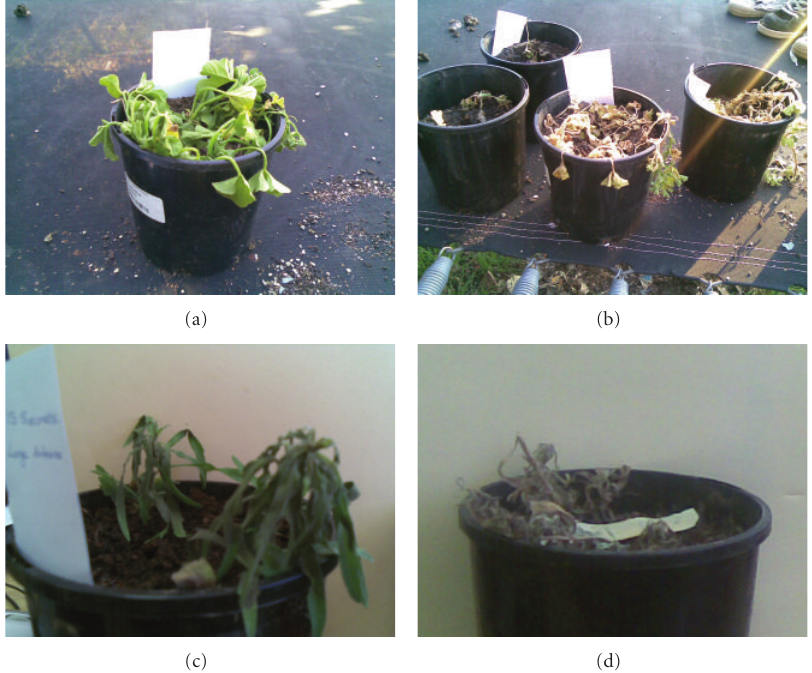
Figure 3: Paddy melon (a) immediately after microwave treatment for 15 seconds and (b) 11 days after microwave treatment and fleabane plants (c) immediately after microwave treatment for 15 seconds and (d) 11 days after microwave treatment using the 130mm by 43 mm aperture horn